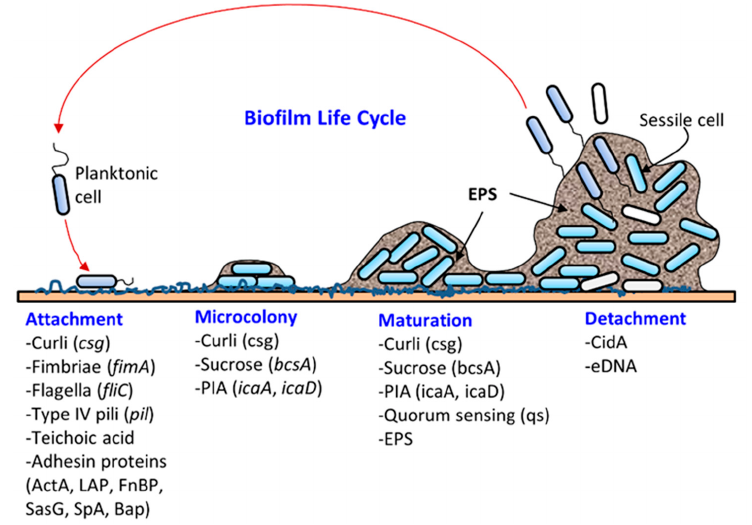
Figure 1. Schematic showing the different stages of biofilm formation (i) attachment, (ii) microcolony formation, (iii) maturation with cellular differentiation, and (iv) detachment or dispersion, and participation of bacterial virulence factors in each step. Abbreviations: ActA, actin polymerization protein; Bap, biofilm-associated protein; bcsA, bacterial cellulose synthesis; CidA, cell death effector protein; csg, curli synthesis gene; EPS, extracellular polymeric substance; eDNA, extracellular DNA; FnBP, fibronectin-binding proteins; icaA, intercellular adhesion; LAP, Listeria adhesion protein; PIA, polysaccharide intercellular adhesin; SasG, S. aureus surface protein G; SpA, S. aureus protein A. Figure adapted with permission from Ray and Bhunia 2014 [15].